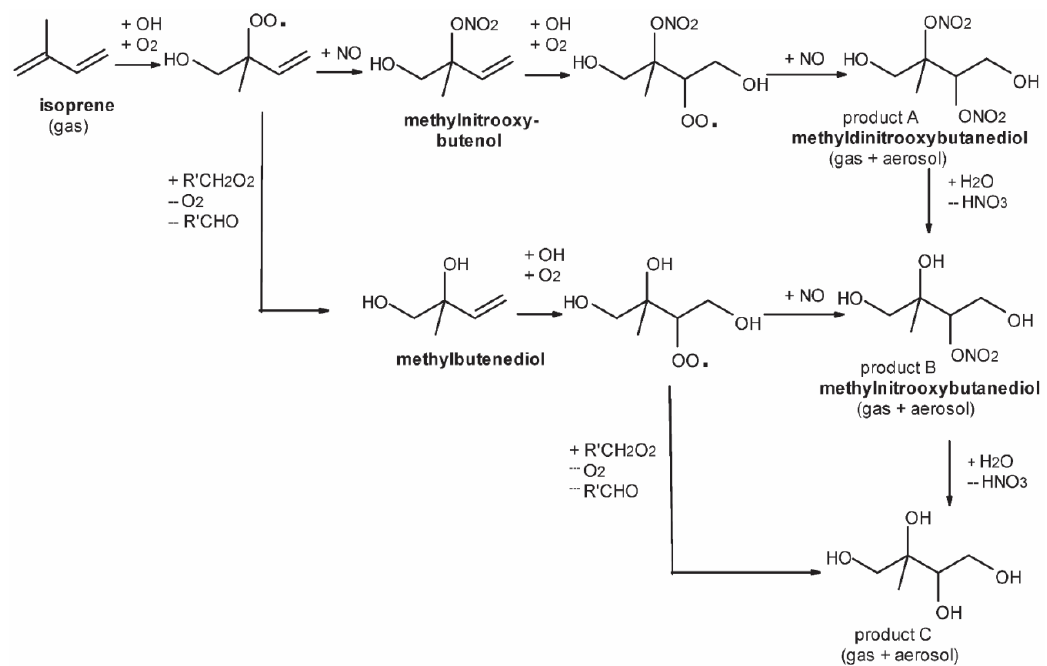
Figure 2. Formation pathway leading to 2-methyltetrols at high-NO x (adapted from Sato, 2008 [7], copyright (2008), with permission from Elsevier).